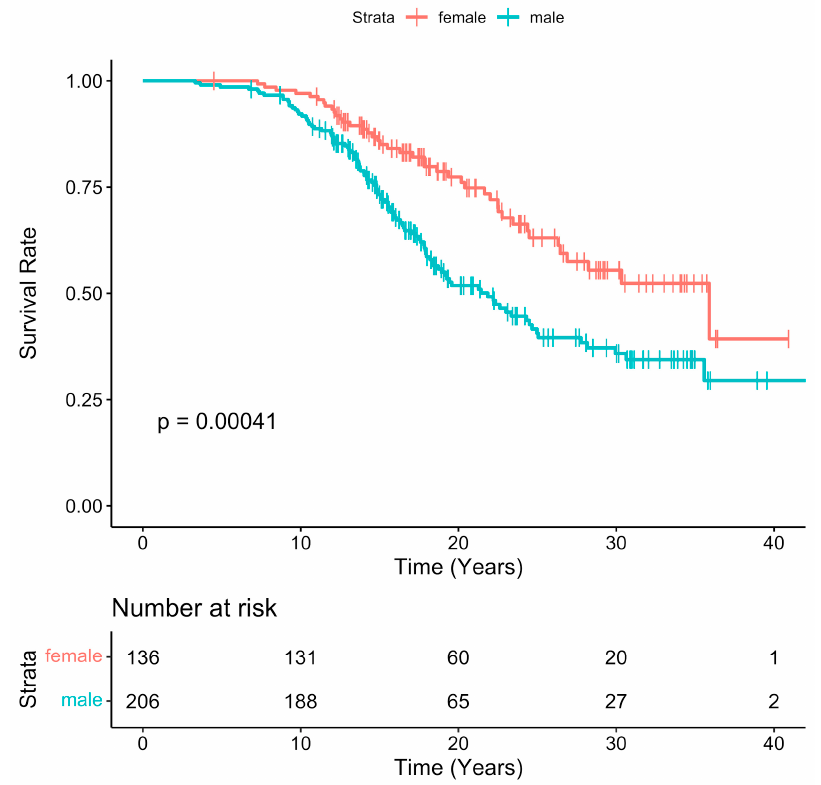
Figure 1. Freedom rate from PVR at the long-term follow-up according to gender. Table 6. Predictors of RV dilation and dysfunction, LV dysfunction. Legend: RVOT = right ventric- ular outflow tract; PAs = pulmonary arteries; BT shunt = Blalock–Taussig shunt; TP = transannular patch; TA = transatrial approach; TVA = transventricular approach; IP = infundibular patch; BMI = body mass index; PR = pulmonary regurgitation fraction; Ref = reference.